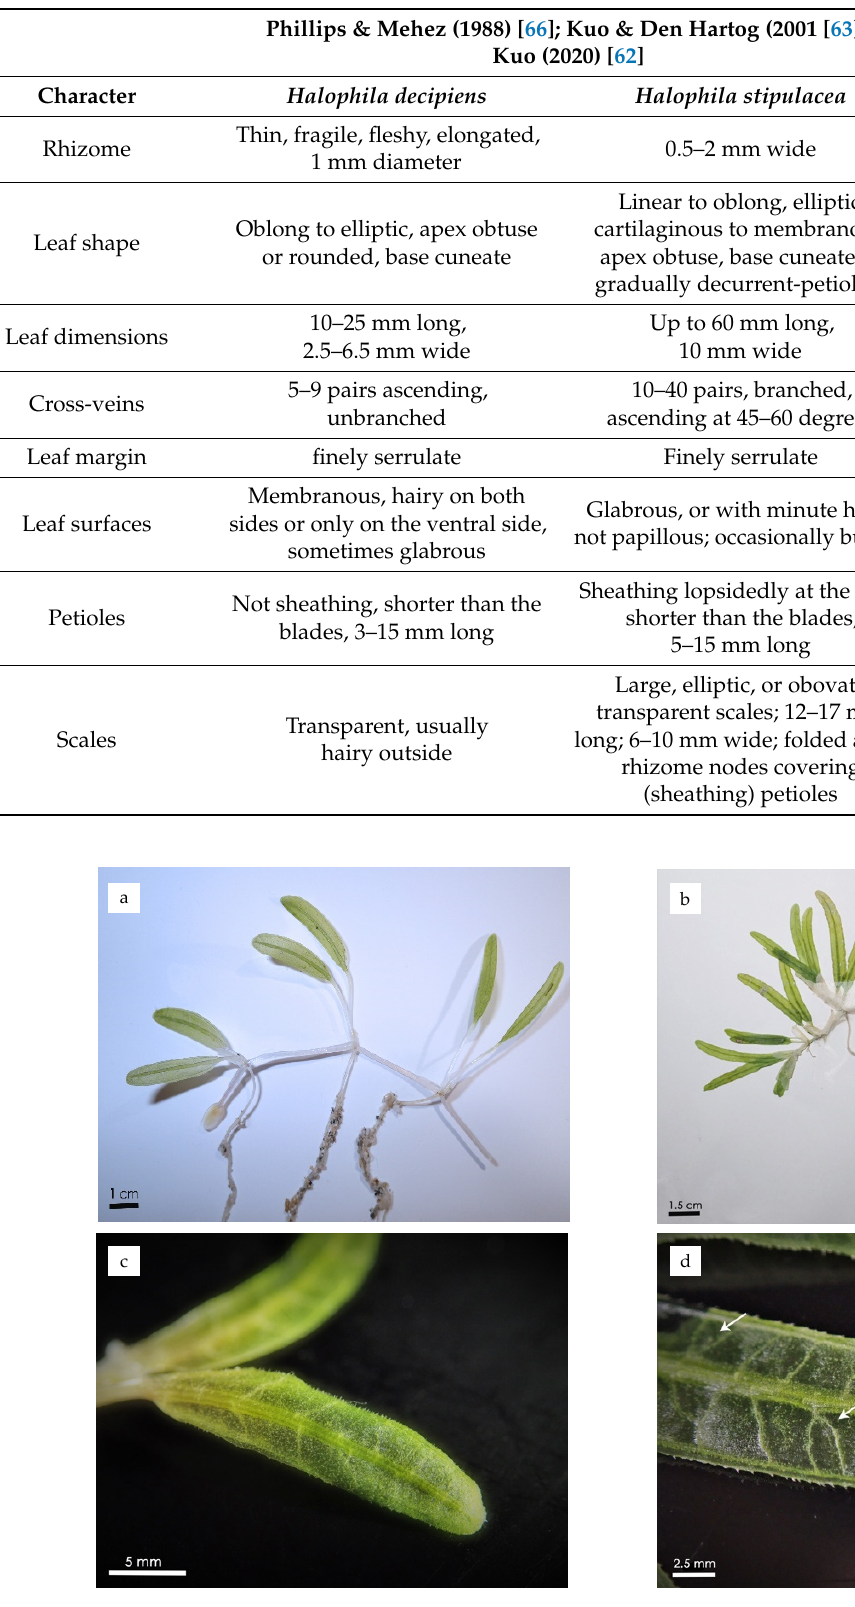
Figure 1. ( a ) A portion of Halophila sp. plant with leaf blades, apical meristem, rhizome, and roots. Scale bar = 1 cm. ( b ) A portion of H. stipulacea plant with linear to oblong leaf blades, scales (black arrows), rhizome, and roots. Scale bar = 1.5 cm. ( c ) Halophila sp. leaf blade with unbranched cross- veins, intra-marginal veins, and midrib. Scale bar = 5 mm. ( d ) H. stipulacea leaf blade showing serrated margin, numerous branched cross-veins (white arrows), intra-marginal vein, and midrib . Scale bar = 2.5 mm. ( e ) Close-up of Halophila sp. leaf blade showing serrate margin and a dense covering of minute unicellular hairs on the surface. Scale bar = 1 mm. ( f ) Close-up of H. stipulacea leaf blade with lack of minute hair and finely serrated margins. Scale bar = 2.5 mm. ( g ) Halophila sp. without persistent scales. Scale bar = 1 cm. ( h ) H. stipulacea showing large, persistent, transparent scales sheathing the petioles of leaf pairs. Scale bar = 5 mm. The photos from the left column are originally from Gerakaris et al., (2020) [39].